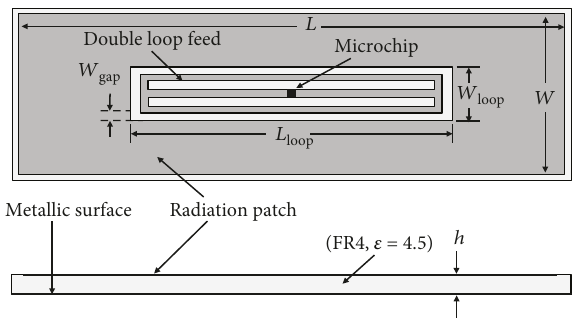
Figure 1: The double loop inductive feed planar UHF RFID tag antenna structure